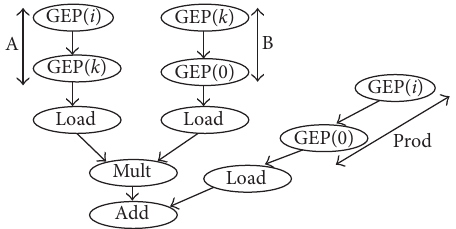
Figure 3: Directed acyclic graph (DAG) of IR for matrix-vector